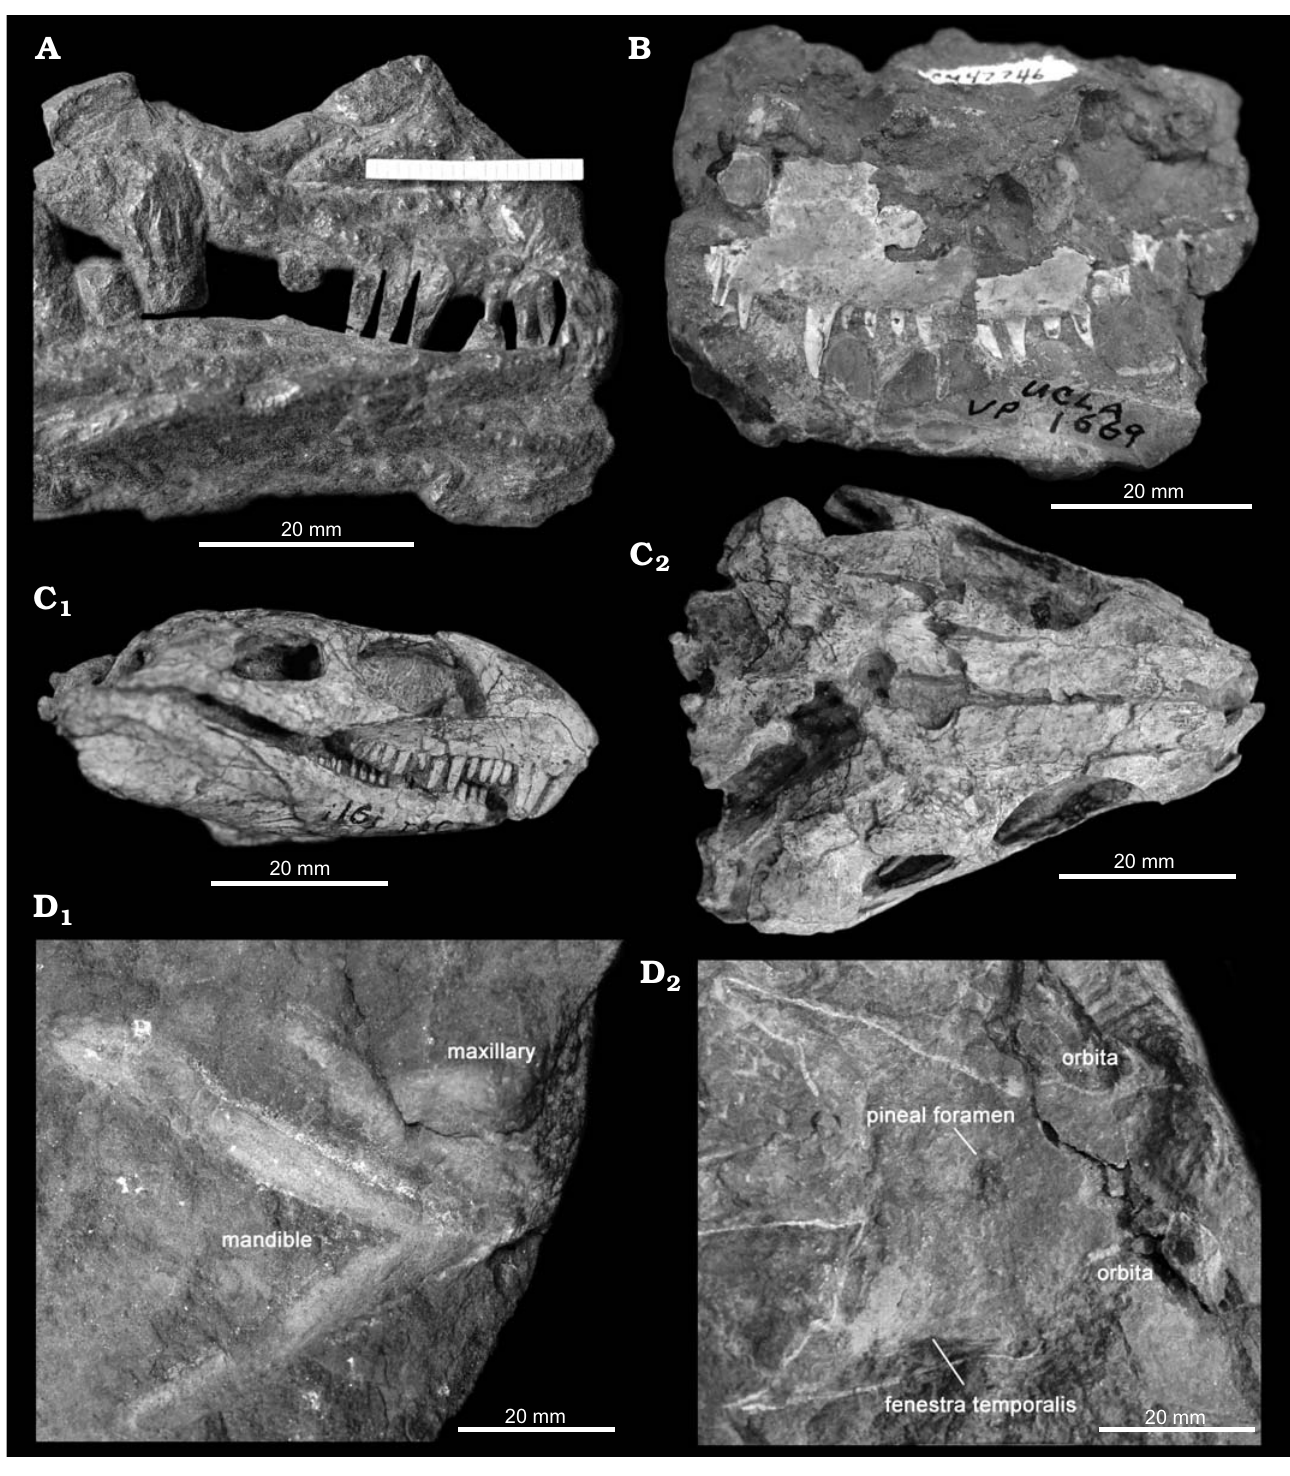
Fig. 6. Skull remains of (putative) basal Caseasauria. A . Callibrachion gaudryi Boule and Glangeaud, 1893, holotype MNHN.F.AUT490 from Margenne (France), Artinskian (Cisuralian). B . ?Eothyrididae indet., CM 47746 from Lisbon Valley (Arizona, USA), Cutler Group (Cisuralian). C . Eothyris parkeyi Romer, 1937, holotype MCZ 1161 from Archer County (Texas, USA), Kungurian (Cisuralian), in lateral (C 1 ) and dorsal (C 2 ) views. D . Datheosaurus macrourus Schroeder, 1904, holotype MB.R. 1015 from Nowa Ruda (Poland), Gzhelian (Pennsylvanian), in ventral (D 1 ) and dorsal (D 2 )